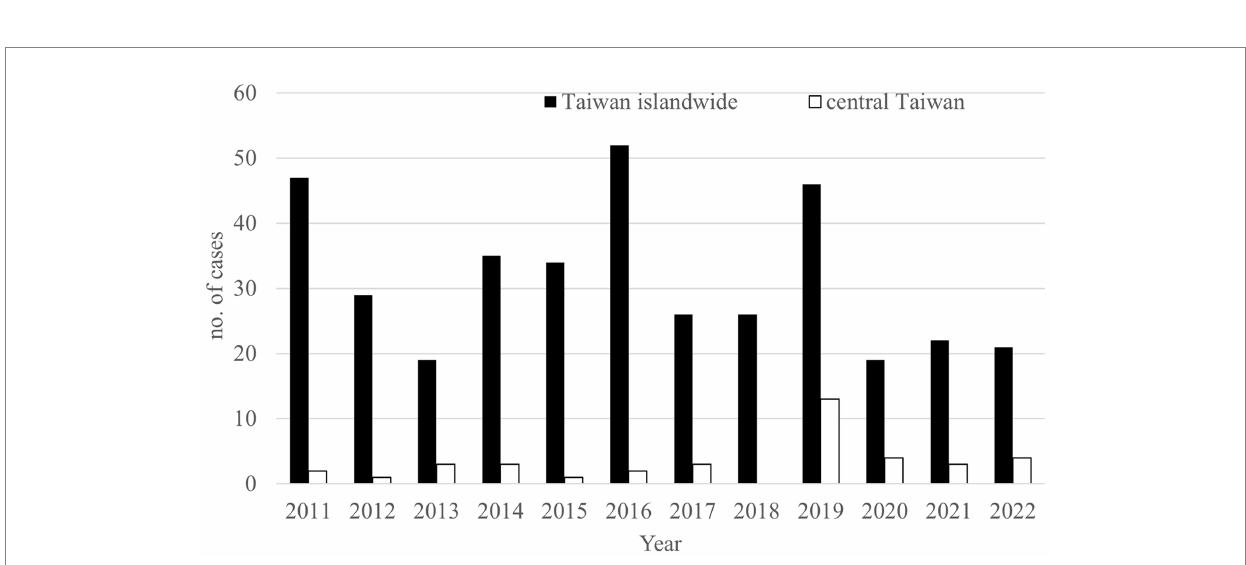
FIGURE 4 The annual numbers of melioidosis reported to the Taiwan Centers for Disease Control (TCDC) from 2011 to 2022. Black bar, national cases reported. Hallow bar, cases living in central Taiwan